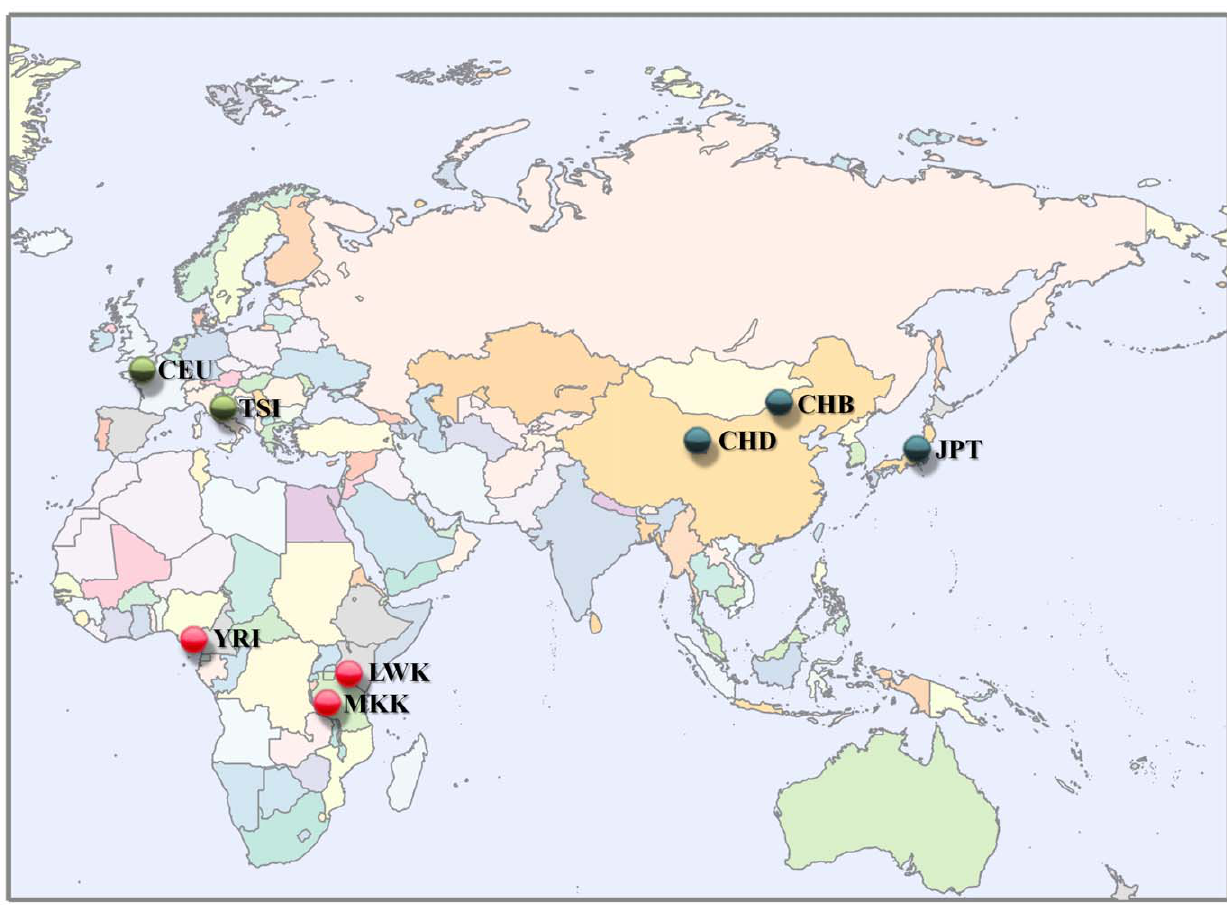
Figure 1. Map of the Old World. The geographical regions of origins are shown for the eight populations used in this study. Intra-continental populations have the same color.